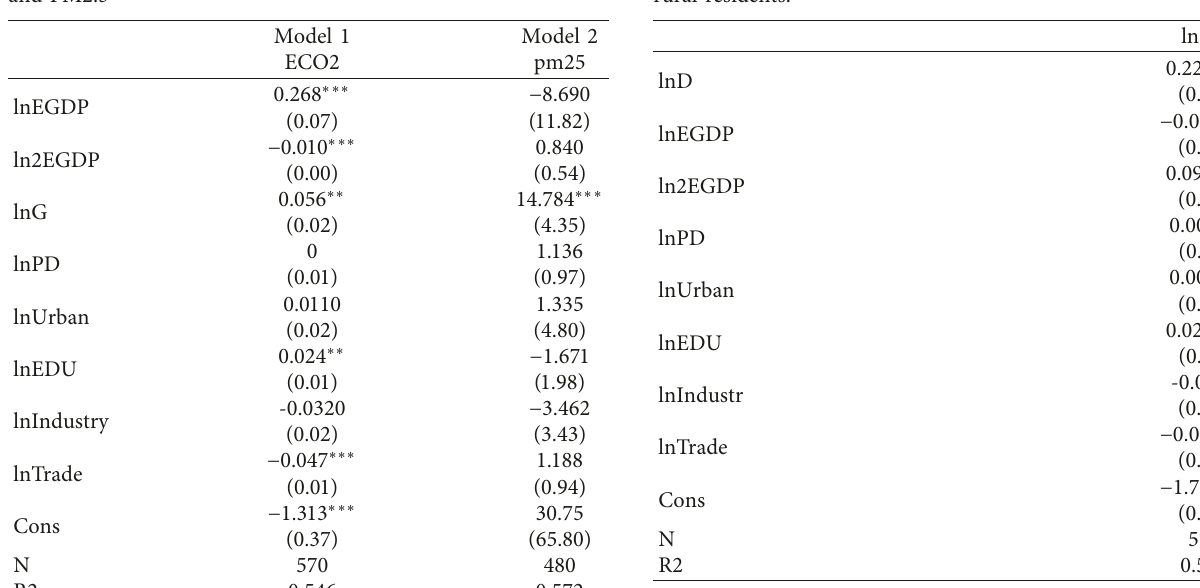
Figure 4: Regional distribution map of carbon dioxide emissions and PM2.5 in 2015. Table 6: Regression results of per capita carbon dioxide emissions Table 7: Regression results of the difference between urban and and PM2.5 rural